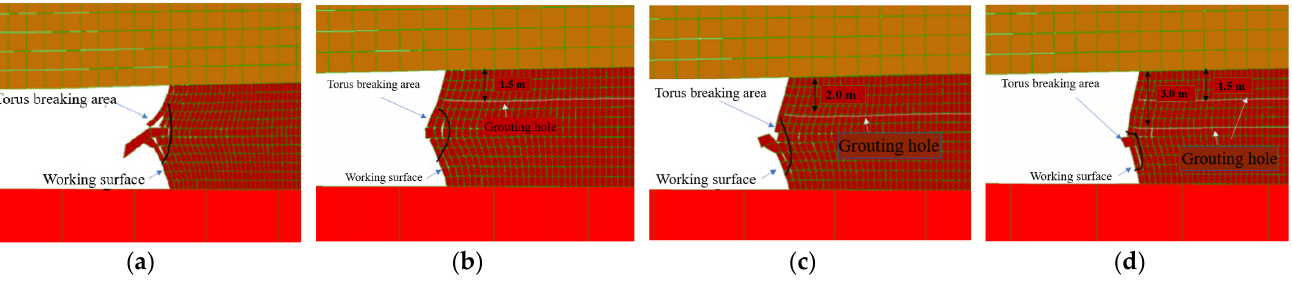
Figure 20. Reinforcement effect diagram of grouting hole at different positions: ( a ) without shoring; ( b ) 1.5 m from the roof; ( c ) 2.0 m from the roof; ( d ) 1.5 and 3 m from the roof.